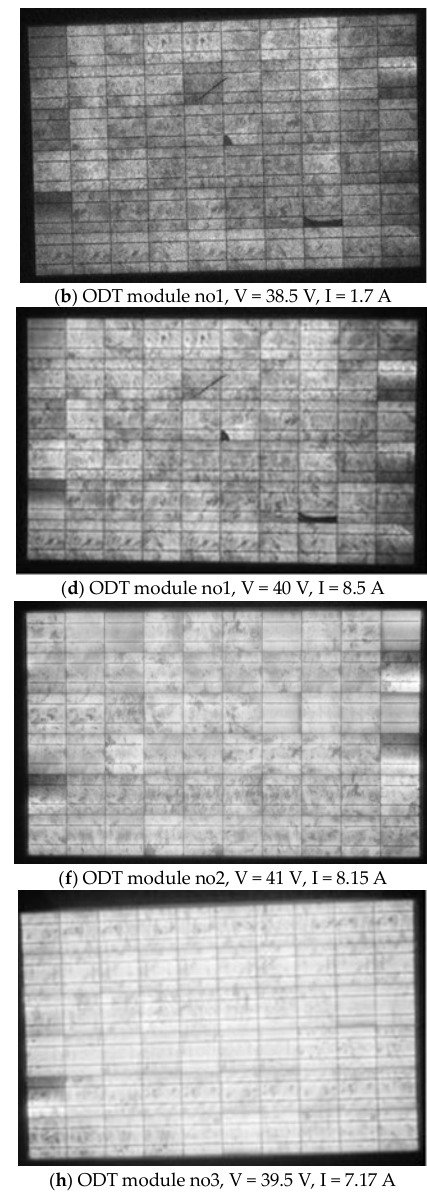
Figure 14. EL images of 3 pc-Si ODT modules that operated for ( a – d ) 5 years, ( e , f ), 4 years, and ( g , h ) 2 years and experienced different degradation effects. The bias V and the allowed I are shown for each case.